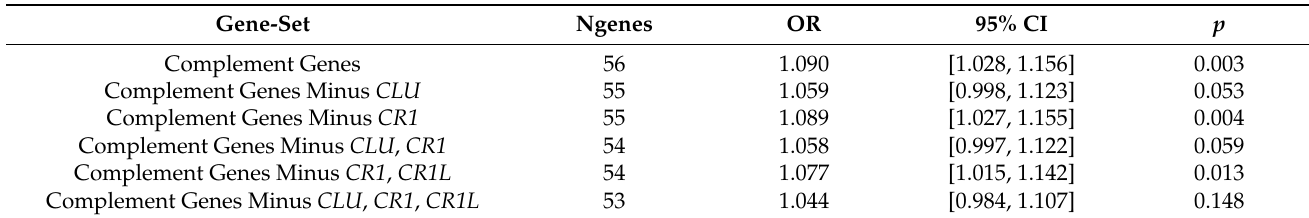
Table 3. Association between Alzheimer’s disease (AD) and complement gene-set risk